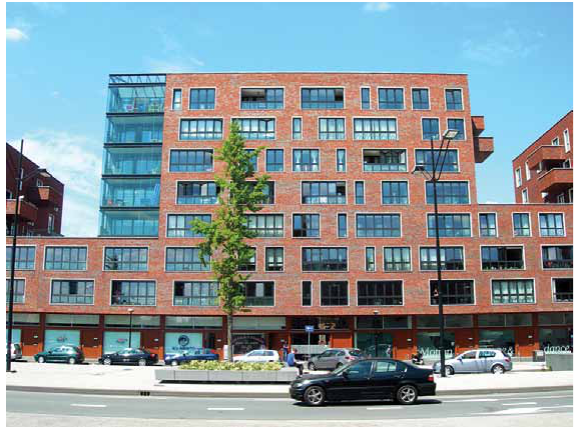
fig. 4. Bijlmermeer estate in amsterdam fig. 5. Bijlmermeer estate in amsterdam